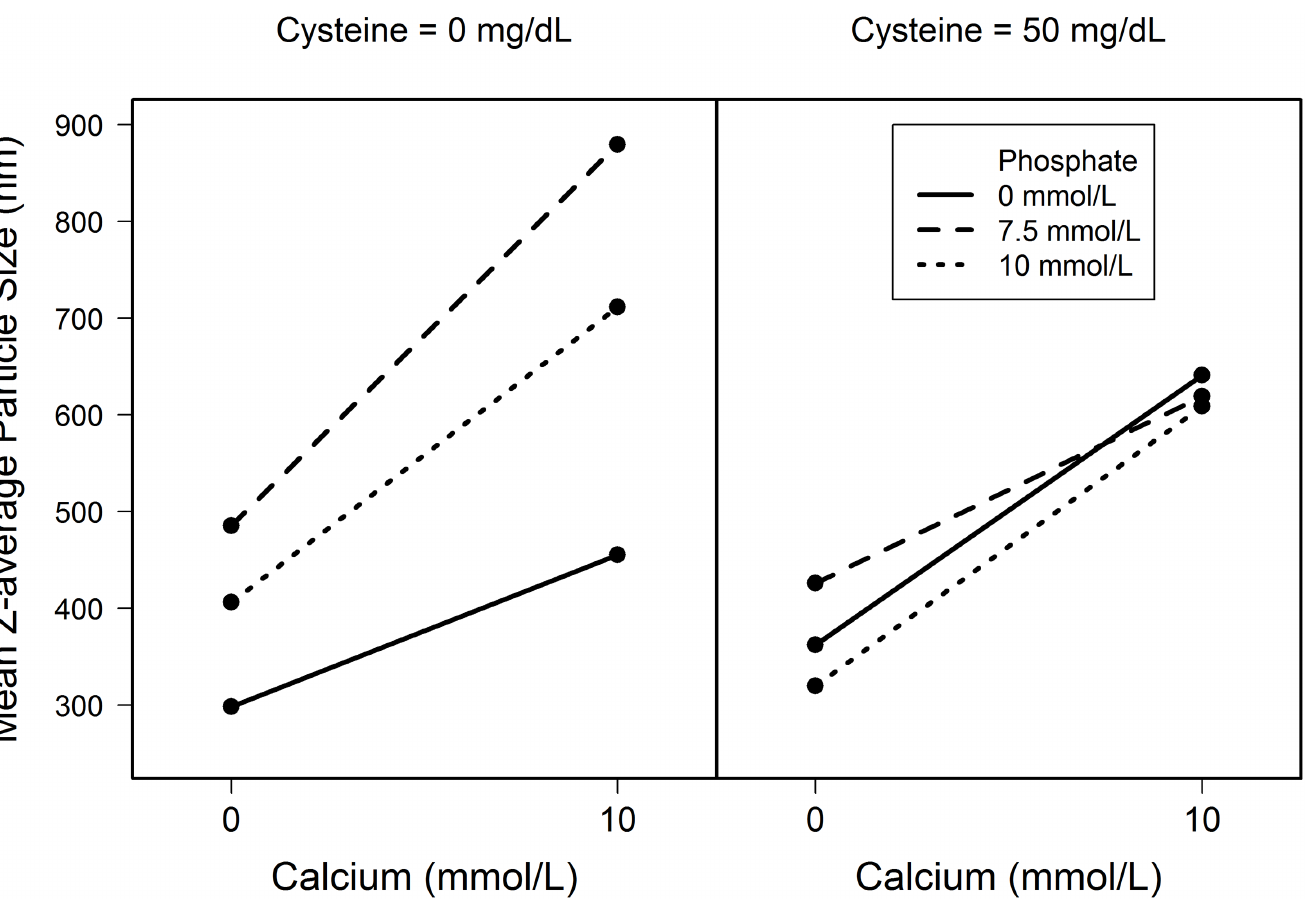
Fig 1. Mean Z-average particle size (nm) for solutions in Study 2. One mmol of elemental calcium equals 40 mg or 2 mEq.